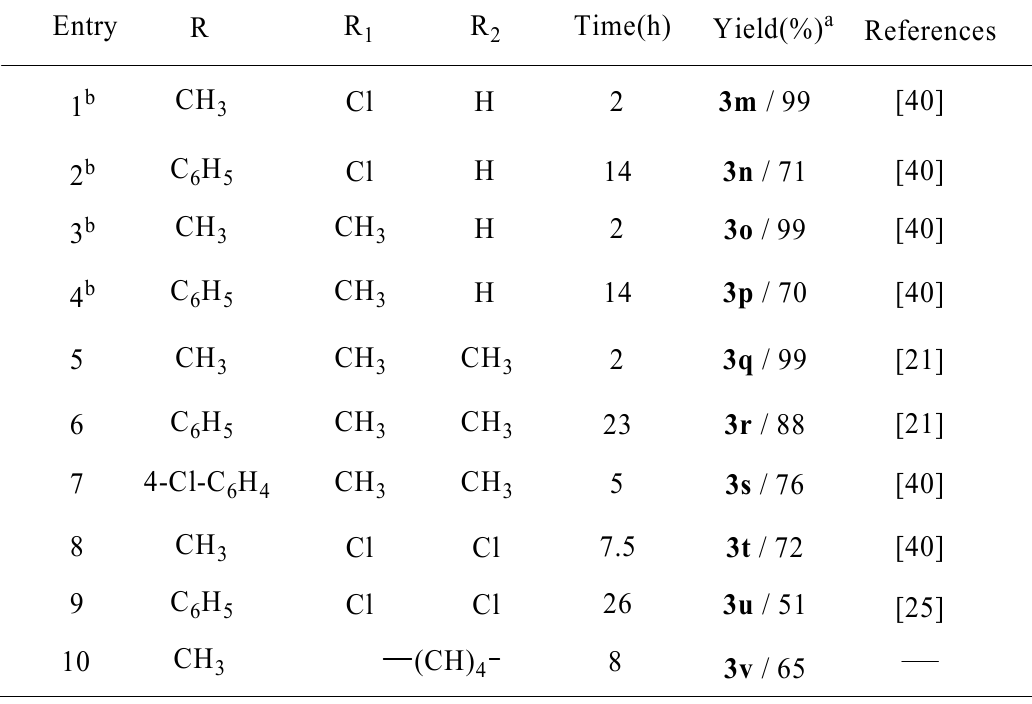
Table 3. The results of the reaction of various o -phenylenediamines with